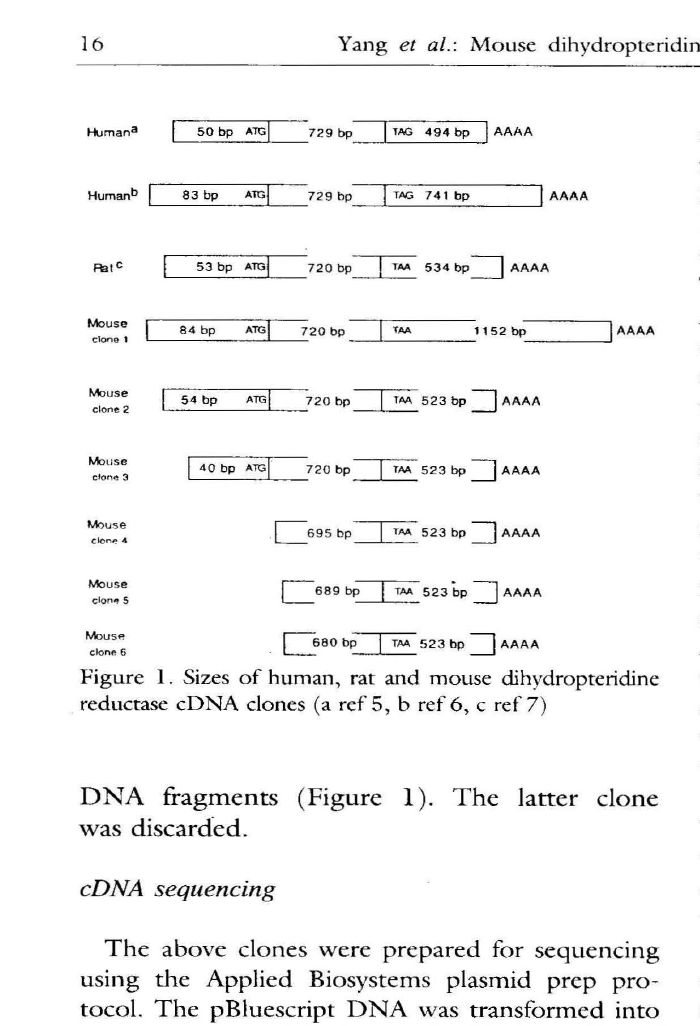
Figure 1. Sizes of human, rat and mouse dihydropteridine reductase eDNA clones (a ref 5, b ref 6, c ref 7)